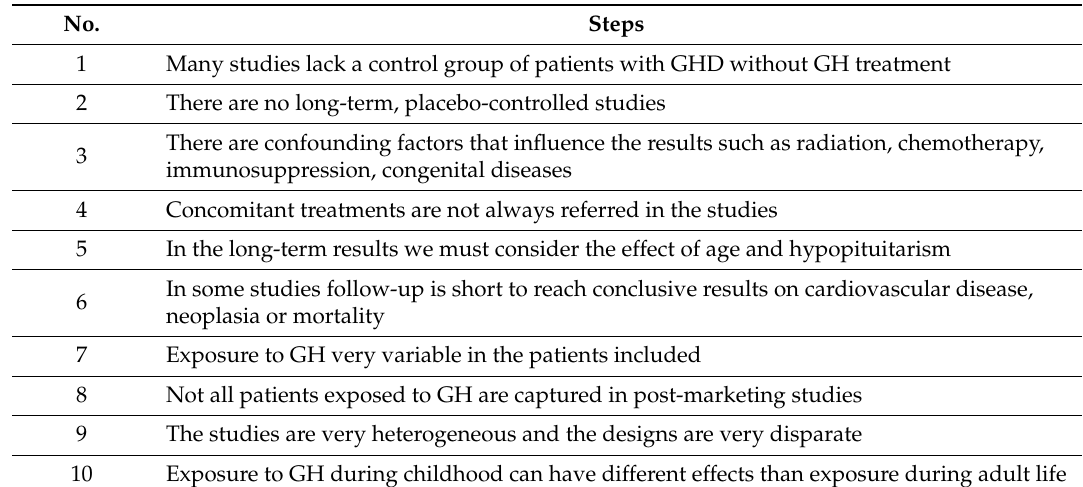
Table 3. Critical evaluation of studies on benefits and risks of GH treatment in adult